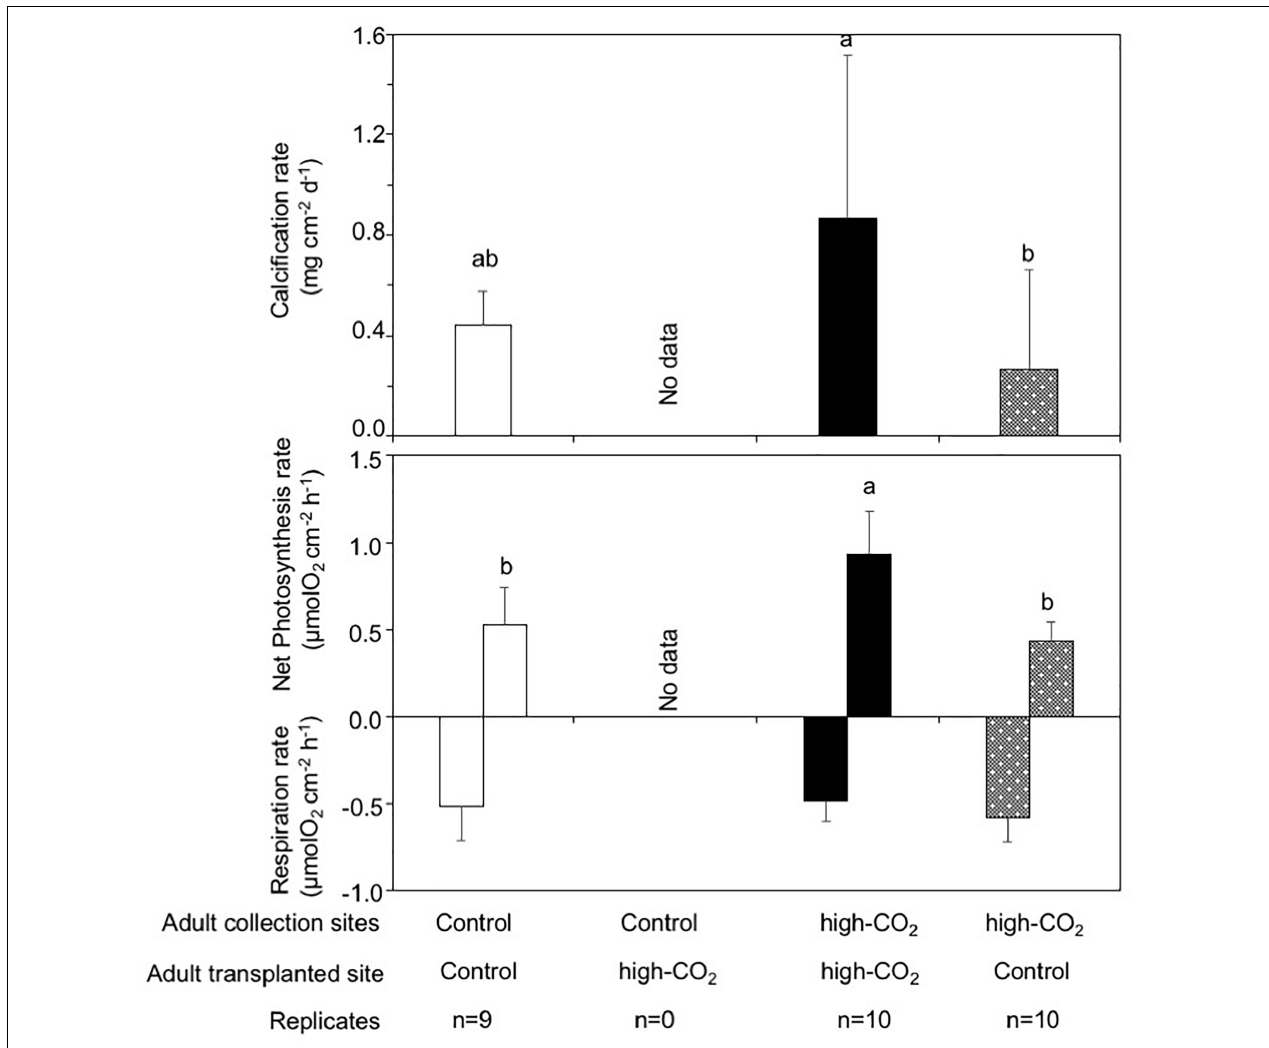
FIGURE 6 | Calcification, net photosynthesis, and respiration of adult corals collected from control and high-CO 2 sites and reciprocally transplanted to control or high-CO 2 site for 7 months. All coral nubbins that were collected from the control site and transplanted to high-CO 2 site died after 7 months. Adult corals collected from the high-CO 2 site and transplanted to their original high-CO 2 site shows significantly higher calcification, net photosynthesis and respiration rates, which are shown by different letters. The replicate number are shown as n in the graph. Average ±